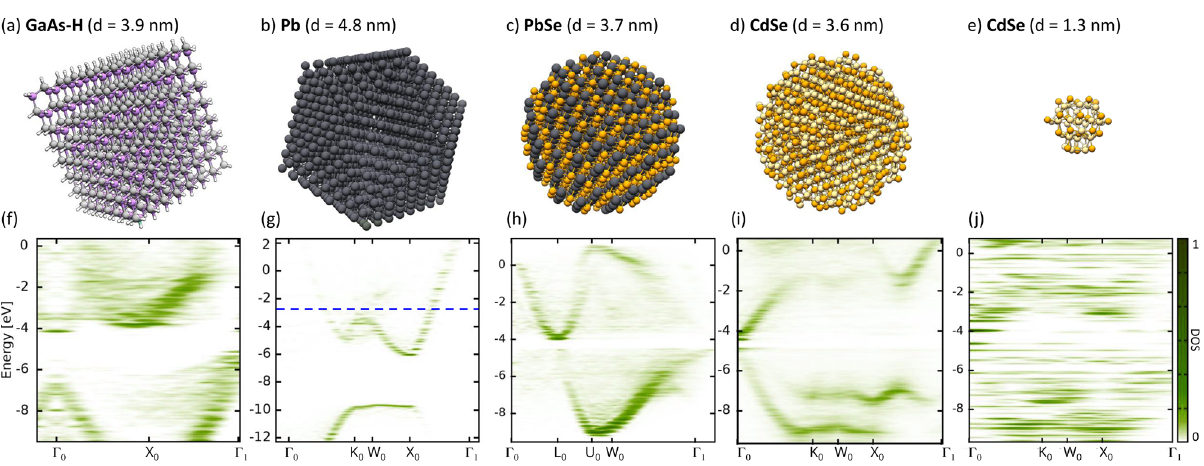
Figure 2. Geometry of ( a ) the GaAs nanocrystal, ( b ) the Pb NC, ( c ) the PbSe NC, ( d ) the CdSe NC, and ( e ) ultra-small CdSe NC. The corresponding quasi-band structures are given in ( f ) for GaAs, ( g ) for Pb, ( h ) PbSe, ( i ) CdSe, and ultra-small CdSe. The dotted blue line indicates the Fermi energy and atoms are given as color coded spheres, Ga (gray), As (purple), H (white), Pb (black), Se (orange), and Cd